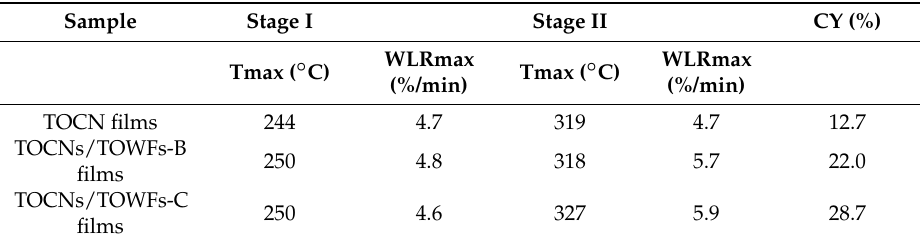
Figure 5. Thermogravimetric analysis (TGA) ( a ) and derivative thermogravimetry (DTG) ( b ) curves of TOCN films, TOCNs/TOWFs-B films, and TOCNs/TOWFs-C films. Table 2. TGA and DTG data measured at a heating rate of 10 ◦